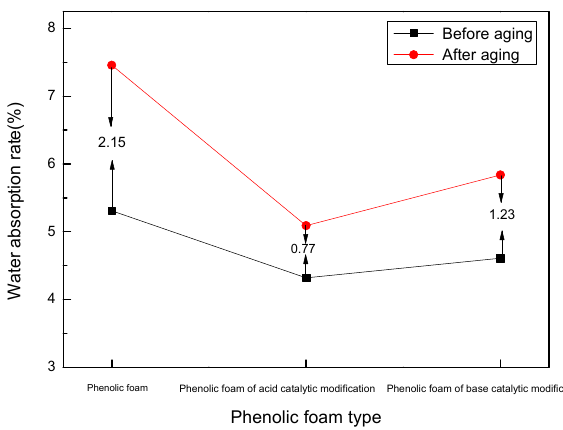
Figure 8. Water absorption rate variation curve of phenolic foam and modified phenolic foam before and after aging.